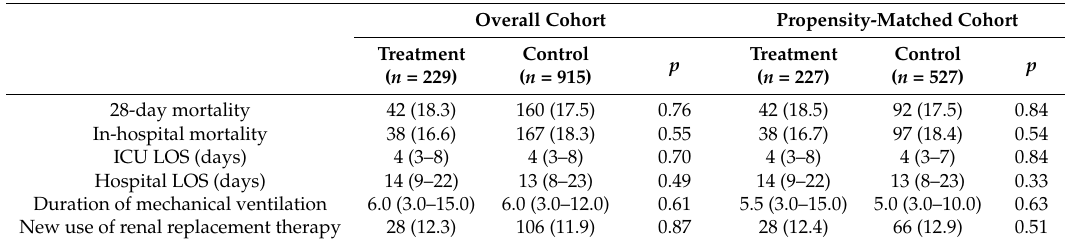
Table 2. Comparisons of primary and secondary outcomes.